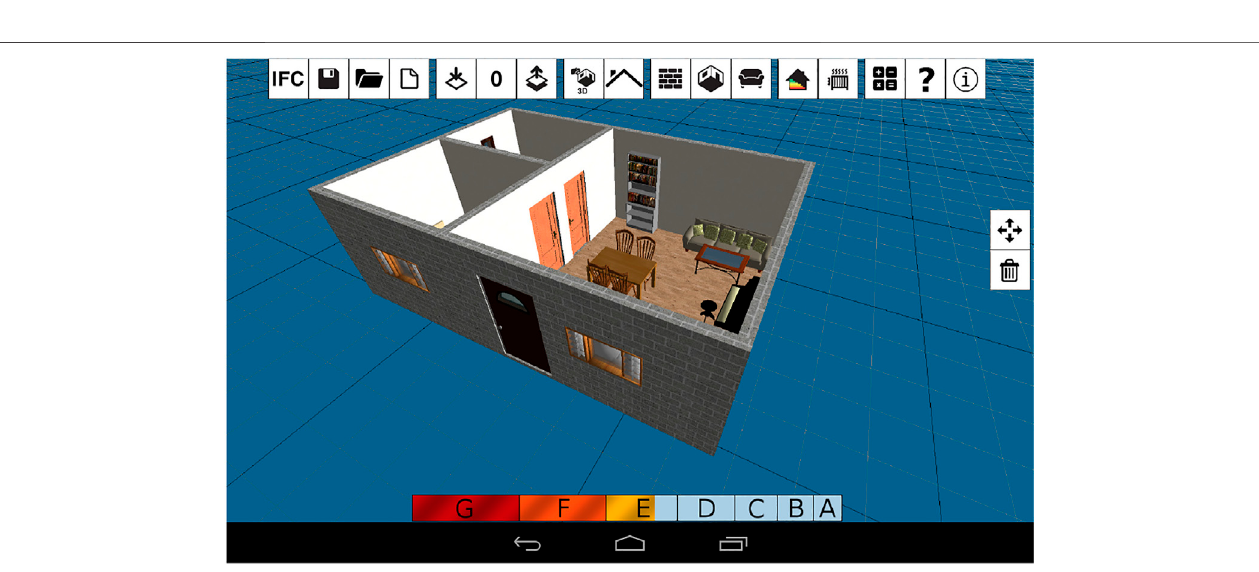
FIGURE 7 | Example of applications: decorating, evaluating energetic